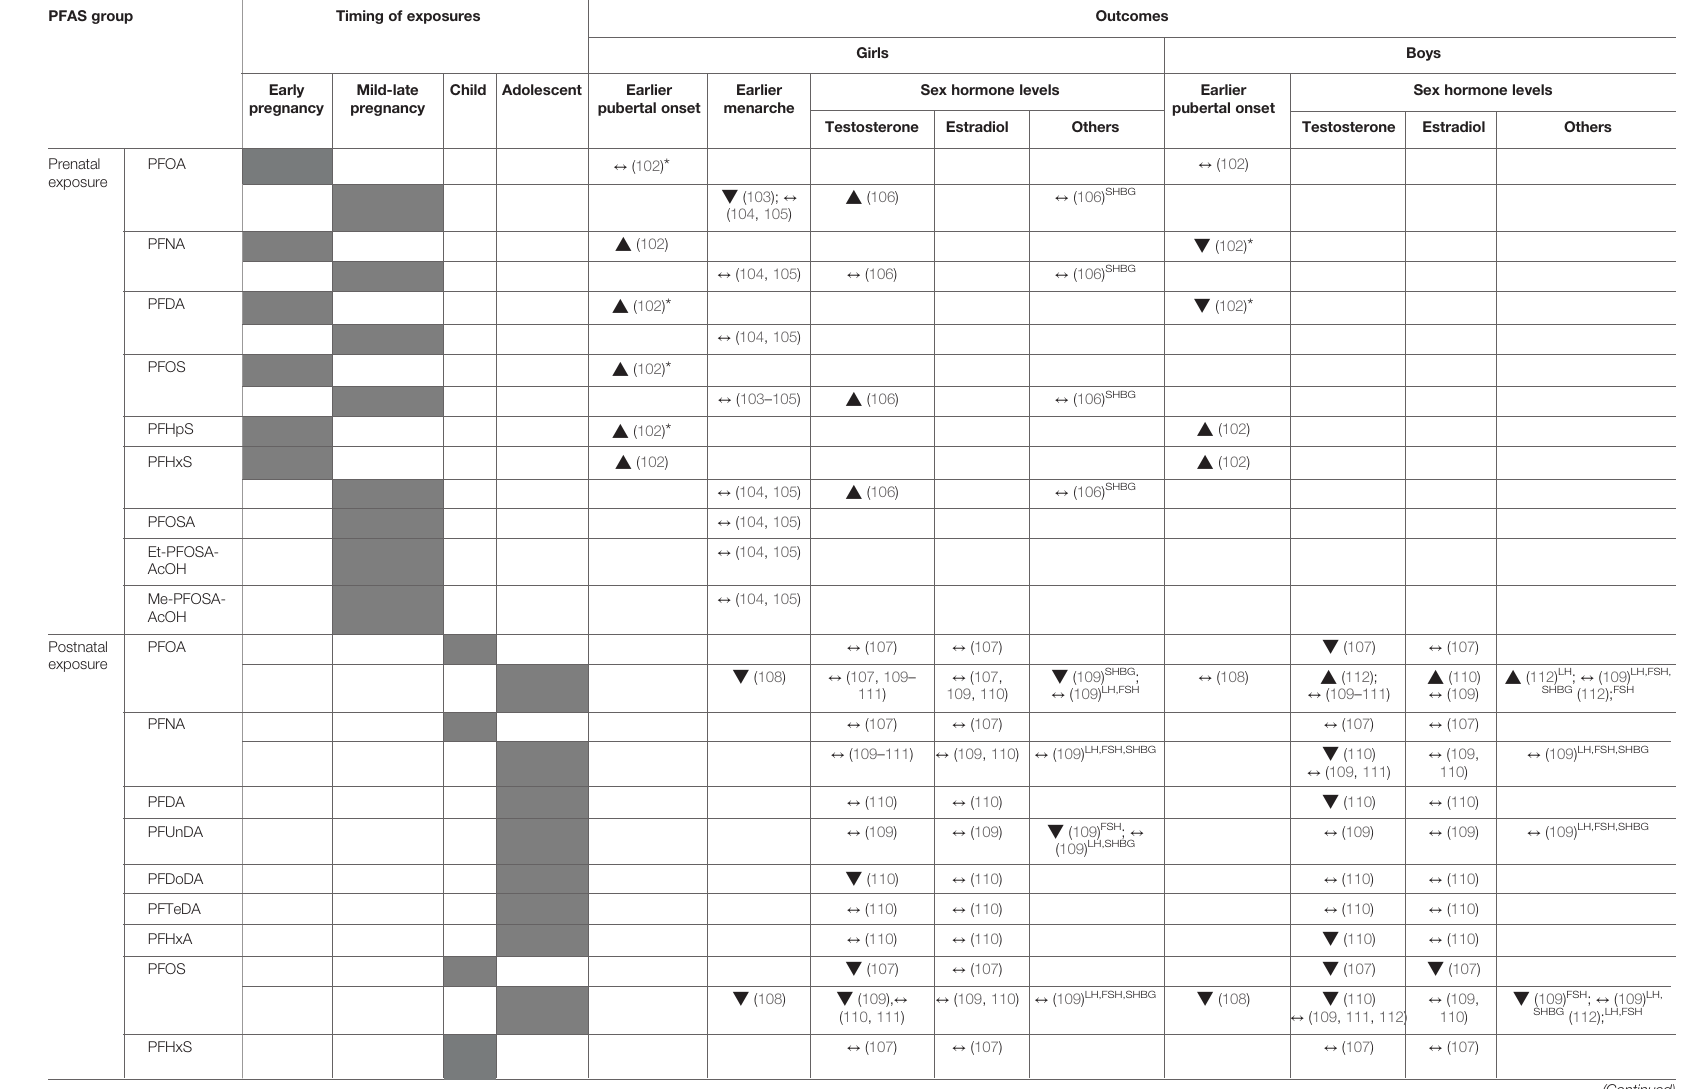
TABLE 4 | Summary of studies assessing associations between PFAS exposure and puberty, menarche, and sex hormone